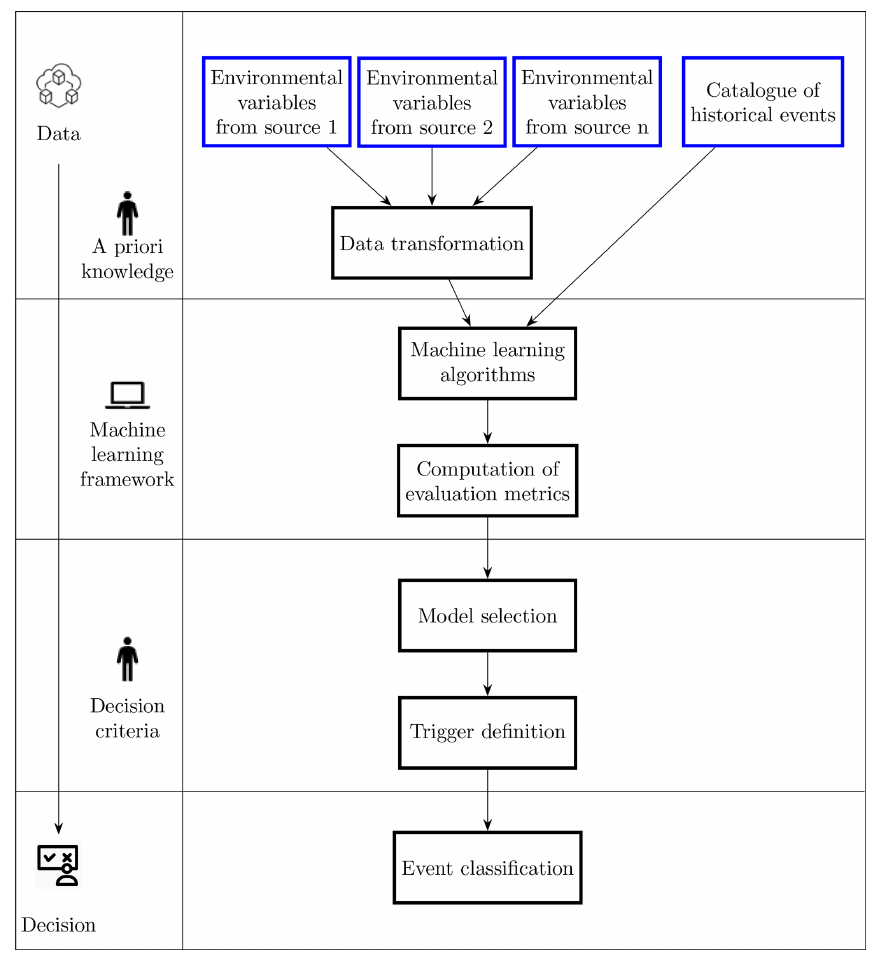
Figure 1. Flowchart of the proposed